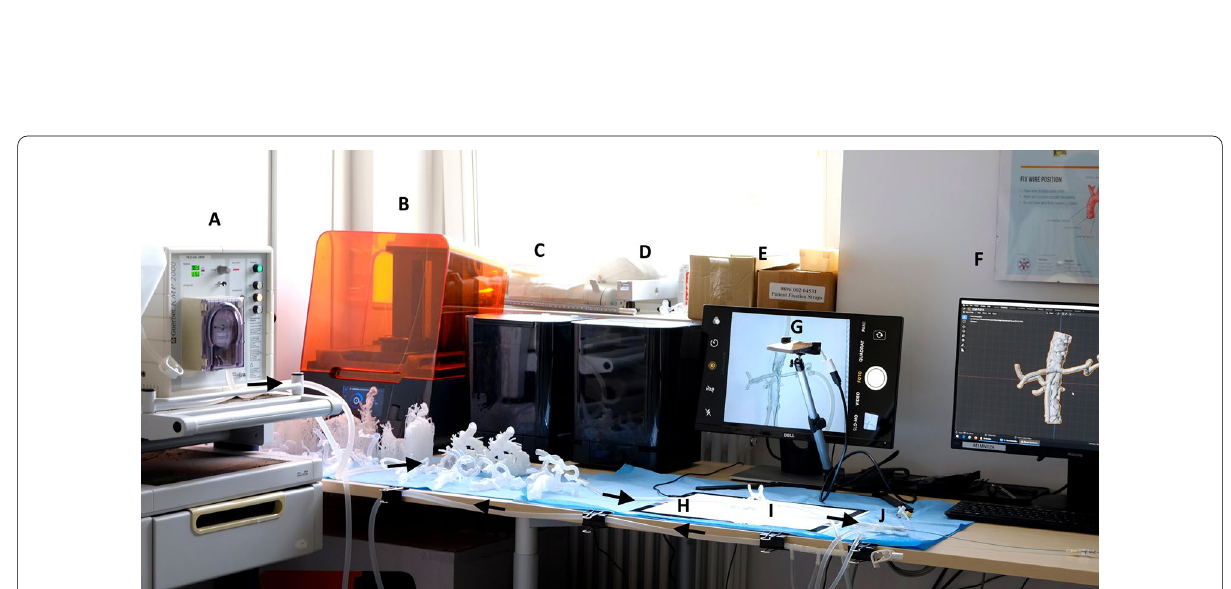
Fig. 4 The 3D printing and simulation setup. This figure illustrates the concept of an in-house 3D print and simulation laboratory. A peristaltic pump, B SLA 3D printer, C Isopropyl-alcohol tank for cleaning of the 3D prints, D ultraviolet curing lamp, E monitor for 2D projection, F computer for segmentation, G smartphone camera on a tripod, H LED panel, I 3D printed vascular model, J 5-French introducer. Black arrows demonstrate the flow direction of the circulatory